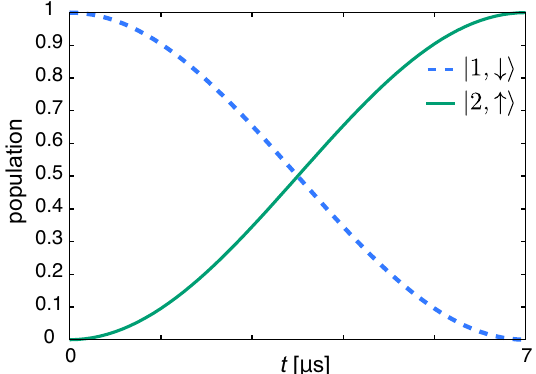
Figure 2. Time dependence of the populations for µ p = − 0.05, B 0 p = 0.1 mT and T stepI = 7 µ